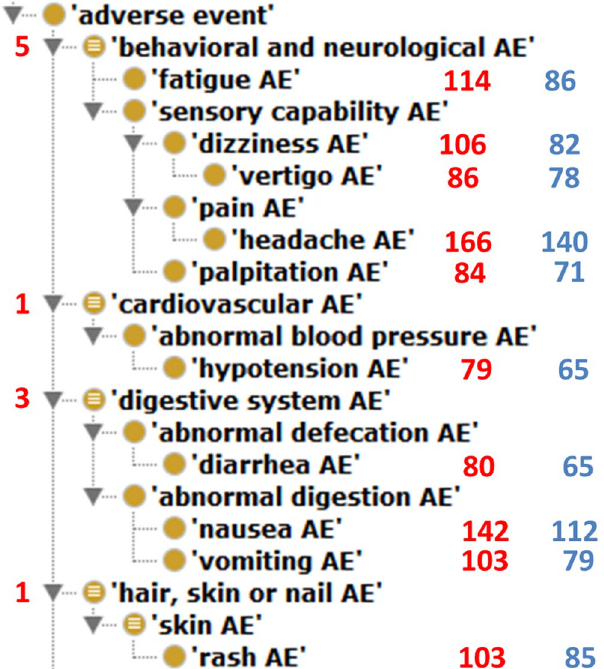
Figure 2. Classification of top 10 AEs associated with CVDs. These OAE terms are visualized using Protégé OWL editor. The left-side digits represent the numbers of specific AEs directly associated with CVDs. The right- side numbers represent the numbers of drugs associated with corresponding AEs. The red color-highlighted right-side numbers come from the total of 259 CVD drugs identified in our study. The blue color -highlighted numbers come from the total of 194 CVD drugs that were mapped to NDF-RT and included in the OCVDAE